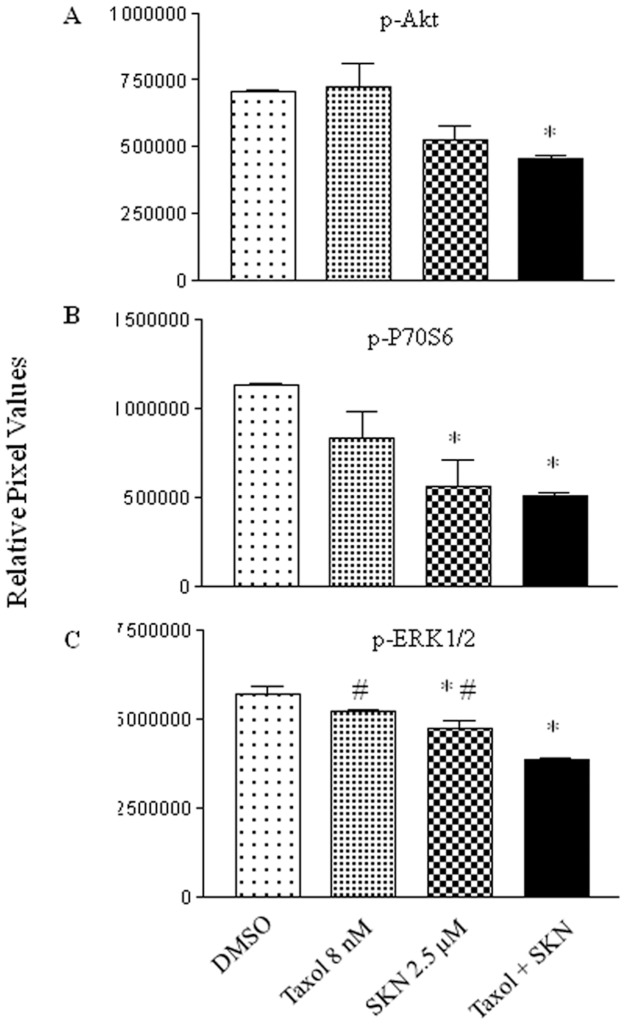
The effect of the combination treatment on key pro-survival kinases.The combination of taxol and shikonin inhibites the activation of Akt (A), p70S6 (B), and ERKs (C). Human phosphor-kinase array analysis was performed following the manufacturer's instruction. Whole cell lysate from MB231 cells treated with DMSO, taxol (8 nM), shikonin (2.5 μM), or the combination. The normalized intensity for each antibody was plotted. * p<0.05 when compared to the control (DMSO); # p<0.05 when compared to the combination.